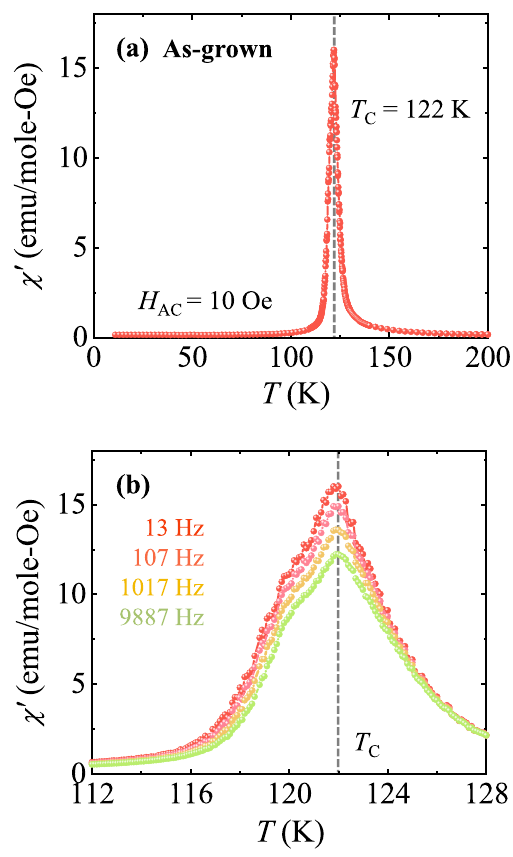
Figure 2. AC magnetic susceptibility for the as-grown crystal. Temperature dependence of ( a ) the real parts of AC magnetic susceptibility, χ ′ , measured at f = 13 Hz under zero DC magnetic-field and AC field excitation of 10 Oe and ( b ) χ ′ at frequencies f = 13, 107, 1017, and 9887 Hz, near T C ( T = 112–128